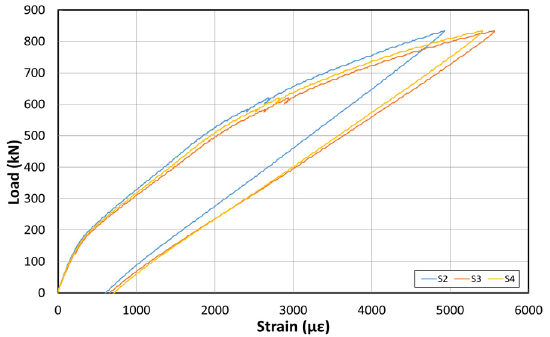
Figure 21. Inner tendon strain curves at the bottom after reinforcement based on the NSM method.